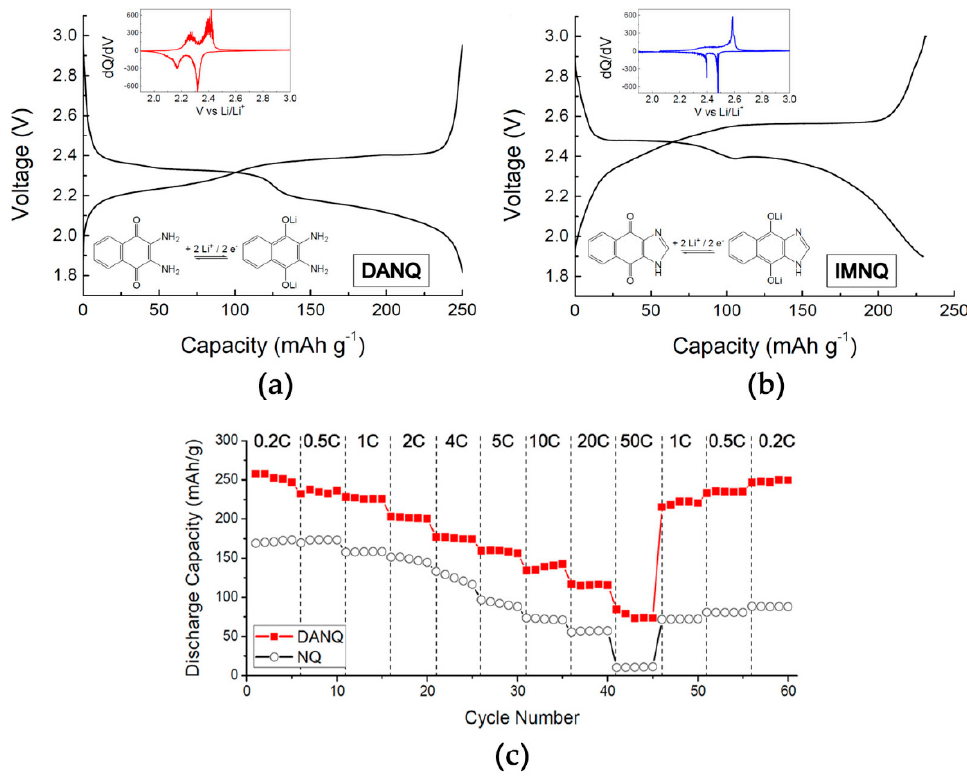
Figure 7. ( a , b ) show two-electron electrochemical lithiation and delithiation of 2,3-diamino-1,4- naphthoquinone (DANQ) and 1H-naphtho [2,3-d]imidazole-4,9-dione (IMNQ), respectively; ( c ) rate performance of the Li-DANQ cell compared to Li-NQ cell. Adapted from [108].